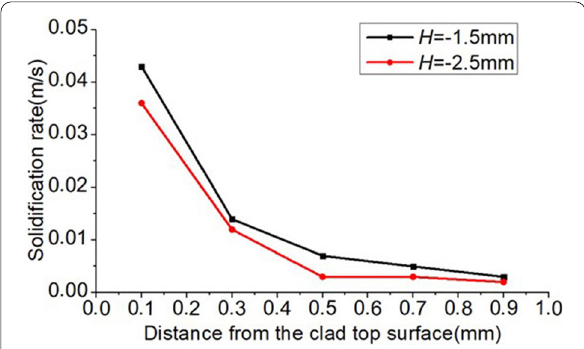
Figure 22 Solidification rates at H